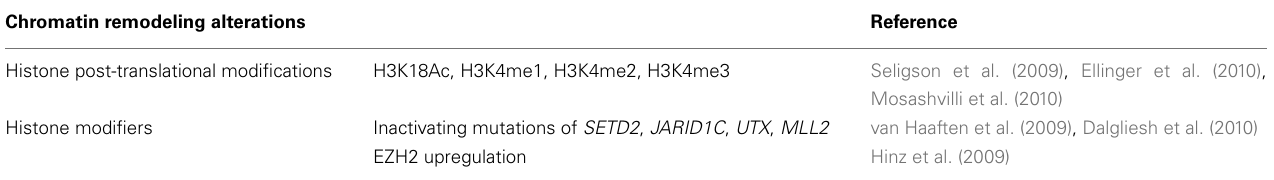
Table 2 | Histone onco-modifications and deregulated modifiers in renal cell